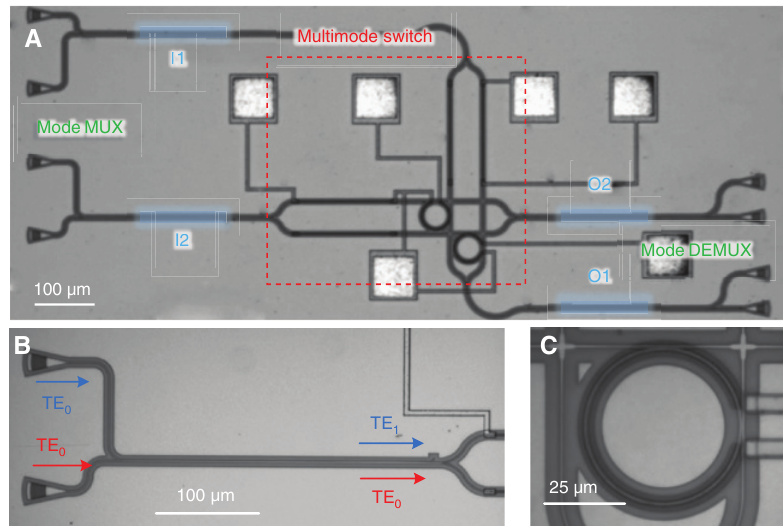
Figure 3: Fabricated multimode switch. (A) Microscope image of the fabricated device consisting of the proposed multimode switch and mode (DE)MUXs. The region highlighted with the red dashed line shows the multimode switch. The areas highlighted in blue show the input/output multimode waveguides. Zoom-in images of (B) the mode MUX and (C) micro-ring